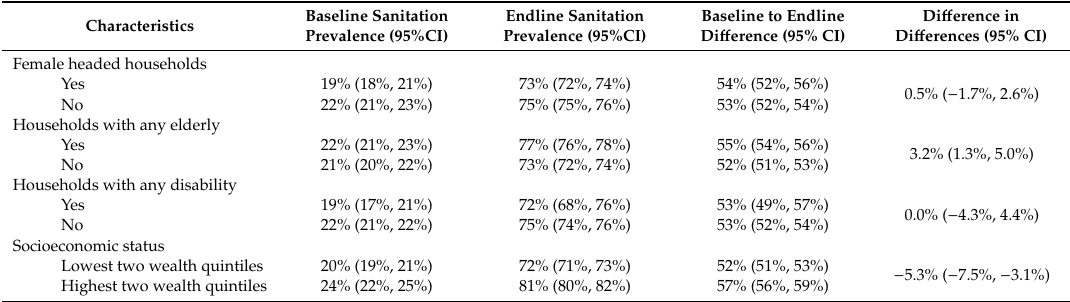
Table 6. Change in coverage of basic sanitation over time, compared between vulnerable and non-vulnerable groups. Data are aggregated across all countries.